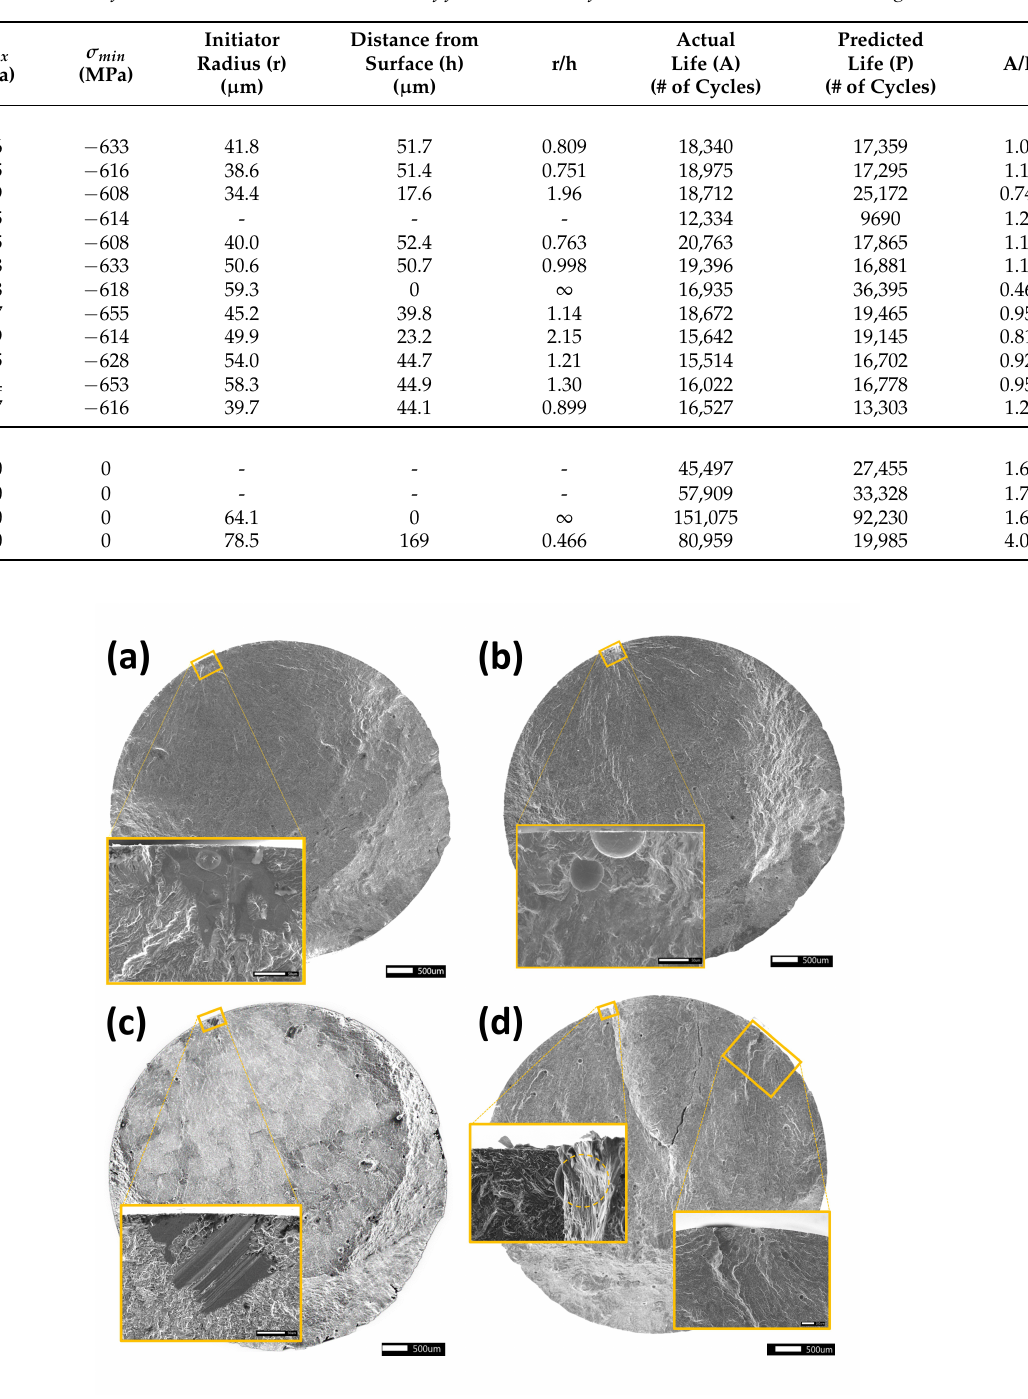
Figure 6. Examples of fracture initiating defects documented via SEM. ( a ) Specimen AL1 with initiation at an LOF defect. ( b ) Specimen AL2 with initiation at a pair of pores. ( c ) Specimen BL3 with multiple initiations on the fracture surface. ( d ) Specimen BL3 with multiple initiations. To the left, a large initiating pore barely visible behind an overhang. The approximate hidden shape is marked with a dashed line. To the right, initiation at a pair of